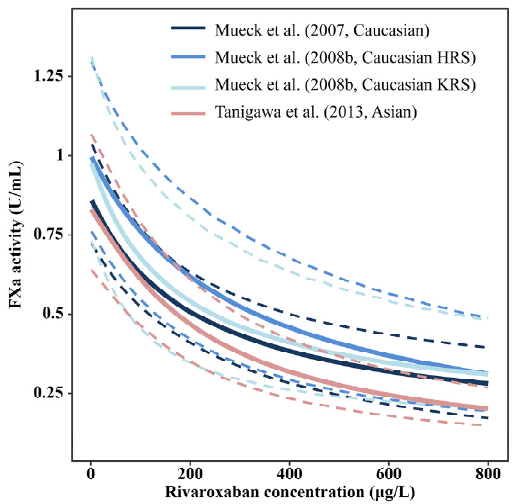
Figure 4. Relationship between Factor Xa activity and rivaroxaban concentration between Asian and Caucasian. The bold, solid, and dashed lines represent the median, 5th, and 95th percentiles of the simulated Factor Xa activity-rivaroxaban concentration profiles in each study, respectively. HRS: patients with hip replacement surgery; KRS: patients with knee replacement surgery [19,22,26].